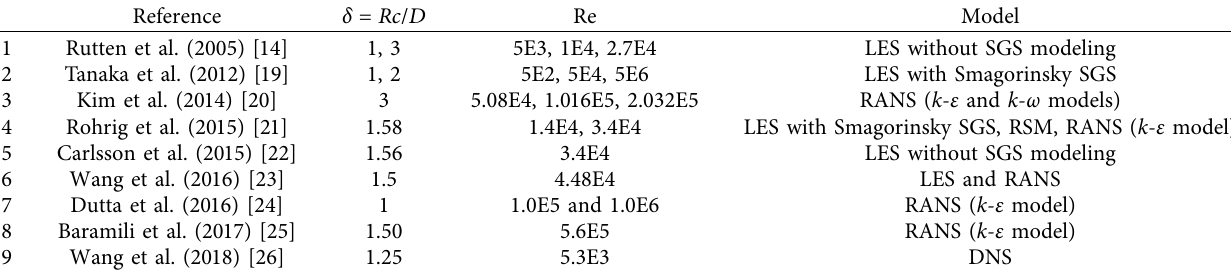
Table 1: Summary of turbulence modeling literature of curved pipes and